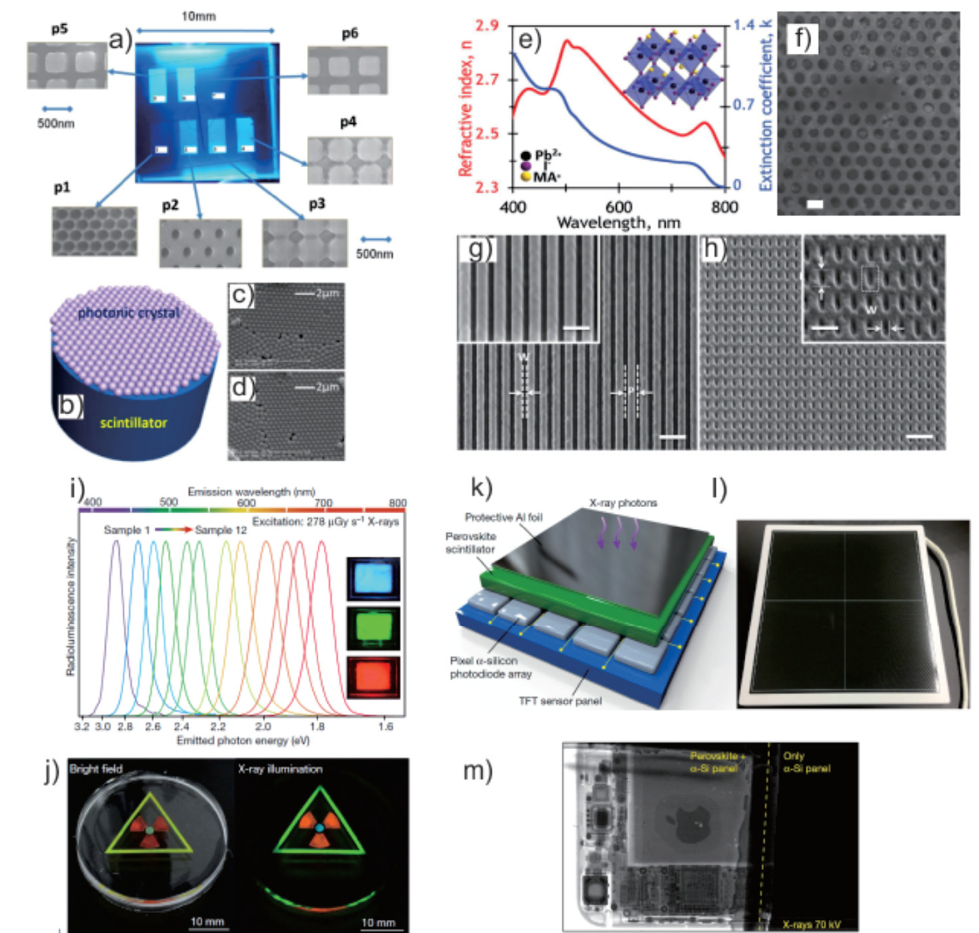
Figure 2. Nanotechnology improvements of scintillators: ( a ) photonic crystals for the extraction efficiency improvements produced with e-beam lithography in Si 3 N 4 on a scintillator; ( b ) schematic illustration of the self-assembled photonic crystal structures covered on the surface of scintillator; ( c , d ) scanning electron microscope image of self-assembled photonic crystals from polystyrene spheres; ( e ) refractive index and extinction coefficient of MAPbI 3 obtained from ellipsometry while the inset shows the crystal structure; ( f ) perovskite photonic crystals fabricated through electron beam lithography; ( g , h ) scanning electron microscope images of nanograting and nanoslit metamaterials from perovskite; ( i ) CsPbX 3 (X = Cl, Br, I) nanocrystals with tunable emission wavelength and high quantum efficiency; ( j ) multicolor X-ray scintillation (left, bright-field imaging; right, X-ray illumination at a voltage of 50 kV) from perovskite nanocrystal scintillator; ( k ) design for X-ray panels with perovskite nanocrystal film (75 µ m thick); ( l ) photograph of the packaged flat-panel detector; ( m ) X-ray images of an Apple iPhone acquired with the perovskite scintillator. Copyright permission from